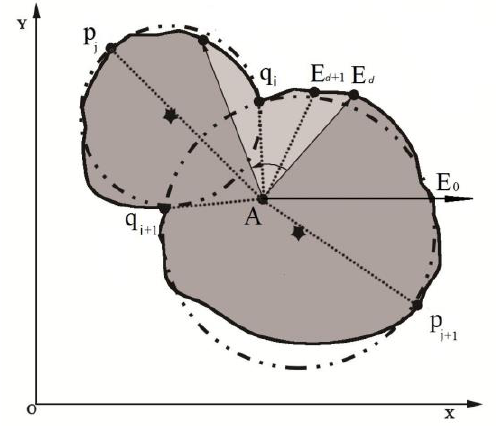
Figure 9. Geometric calculation model of the extreme value points of the boundary of two lychees in the foreground region. Output: Location and size of every single lychee fruit in the foreground region C n .